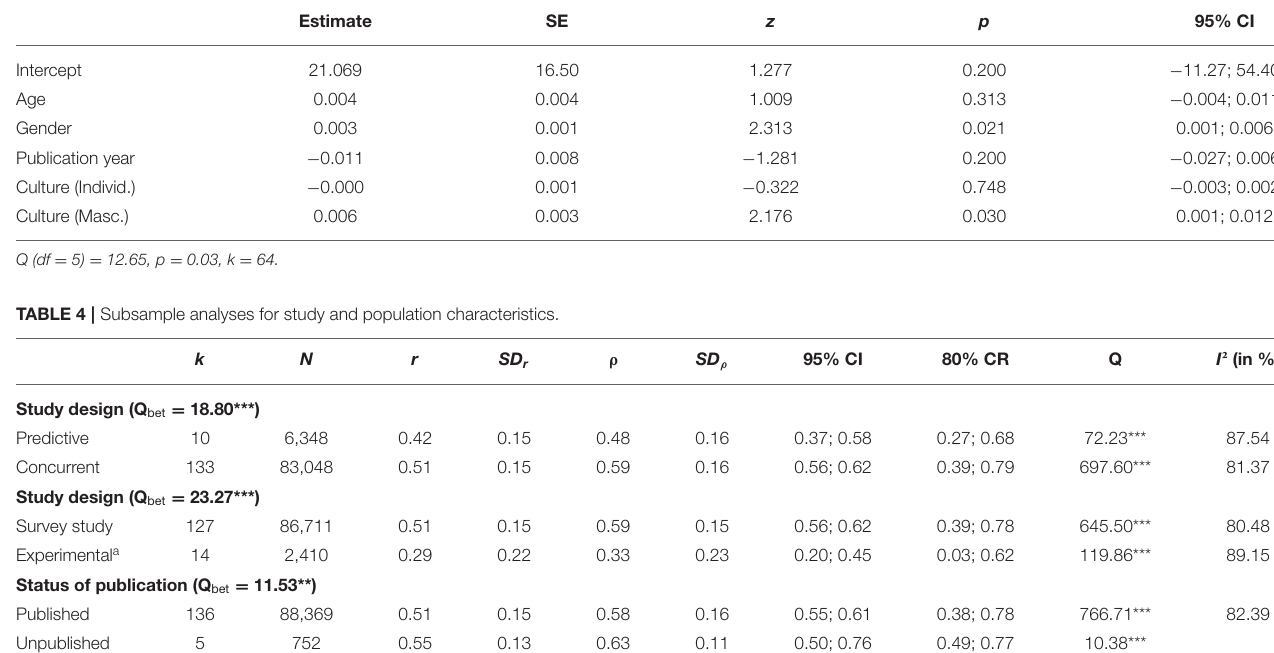
TABLE 3 | Metaregression (test of continuous moderators).